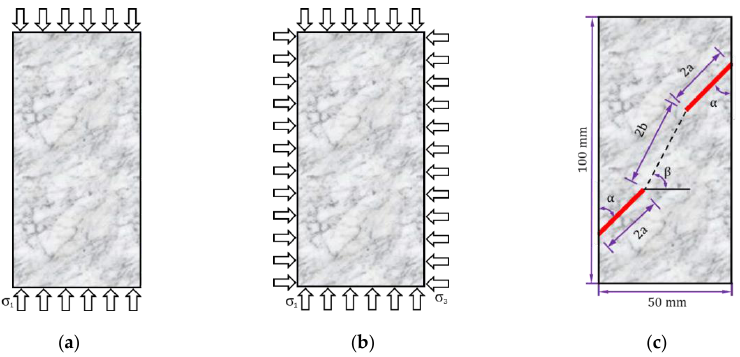
Figure 3. Schematics of intact rock specimen under ( a ) uniaxial compression and ( b ) triaxial compression. ( c ) Geometry of pre-fissured marble specimens. ( c ) Geometry of pre-fissured marble